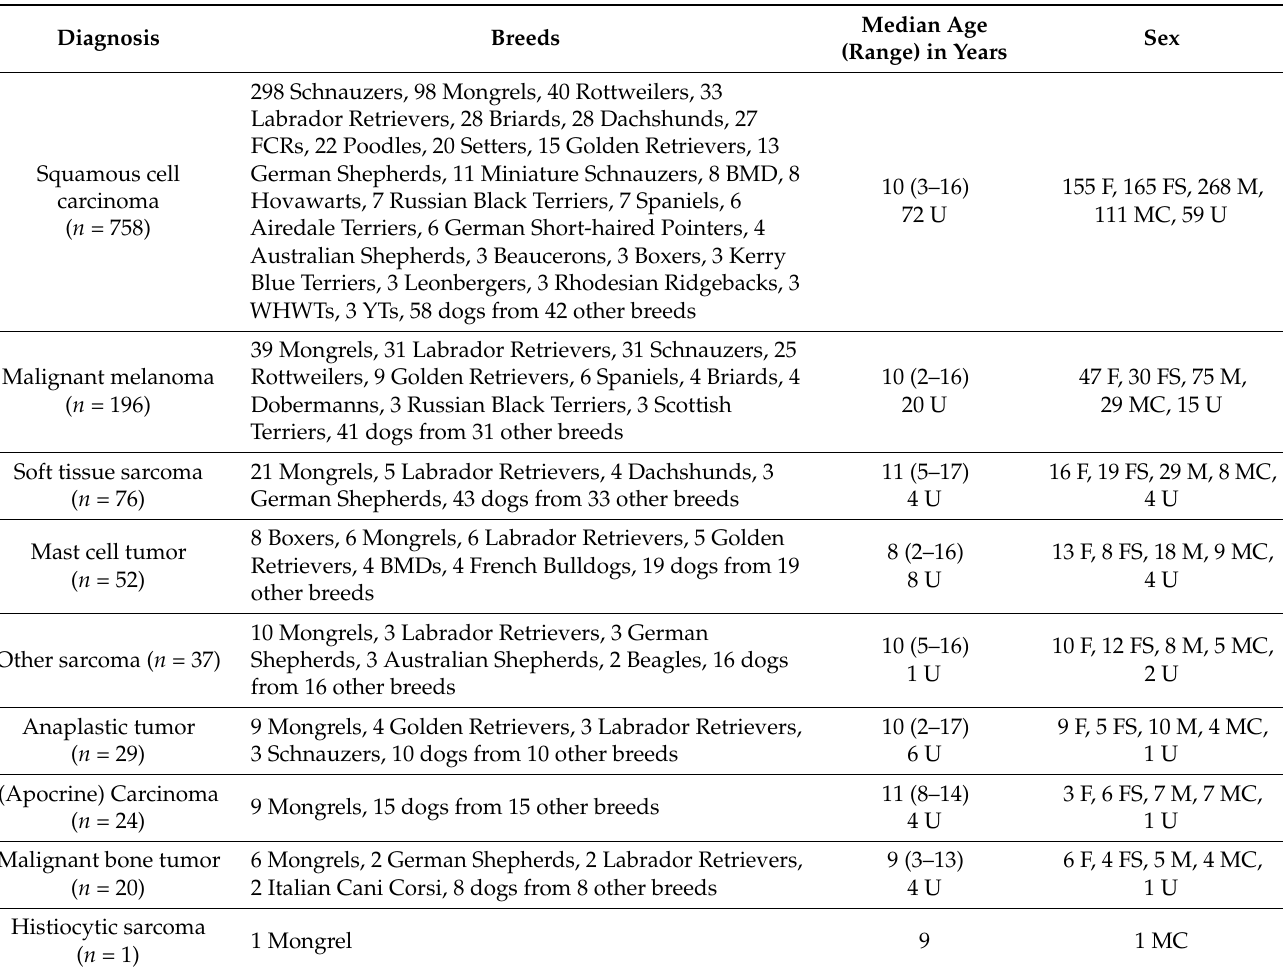
Table 4. Signalment of the 1193 dogs with malignant tumors (group